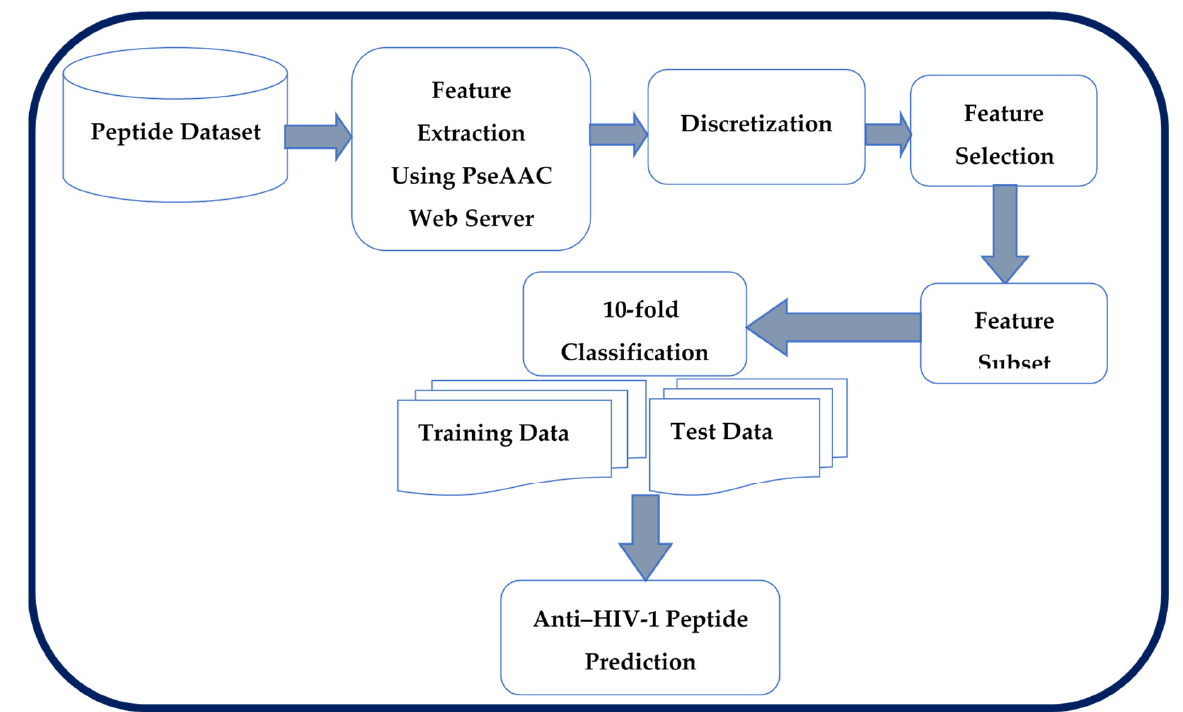
Figure 1. The Proposed Framework.